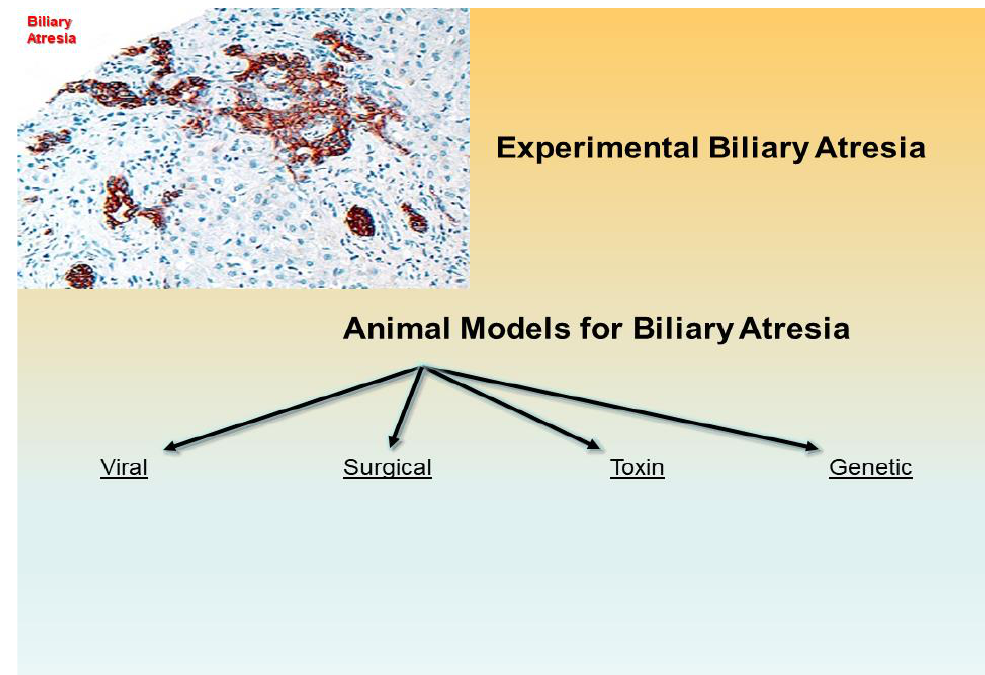
Figure 1. Experimental biliary atresia with fibrosis and bile duct proliferation of biliary epithelial cells in the portal tracts is evidenced by immunohistochemistry with an anti- body against keratin 7 (intermediate filament of the cytoskeleton) (x200 as original mag- nification). An experimental biliary atresia may be setup with several laboratory animals with lines of scientific progress of this and last centuries toward viral, surgical, toxin- based, and genetic animal